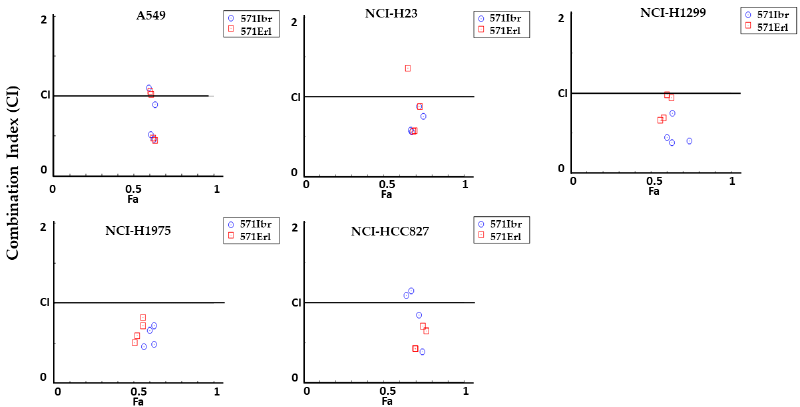
Figure 7. Combination index (CI) plots for apoptosis (Annexin V/PI) in lung cancer cell lines incubated (24 h) with a combination of KAN0441571C (250 nM) with ibrutinib (571Ibr) (blue symbols) or erlotinib (571Erl) (red symbols) (5000–10,000 nM, see Figure 6). Values across Fa in lung cancer cells are shown, where Fa is the % of cell death. CI < 1 synergistic effect; CI = 1 additive effect; CI > 1 antagonistic effect (Chou–Talalay method).